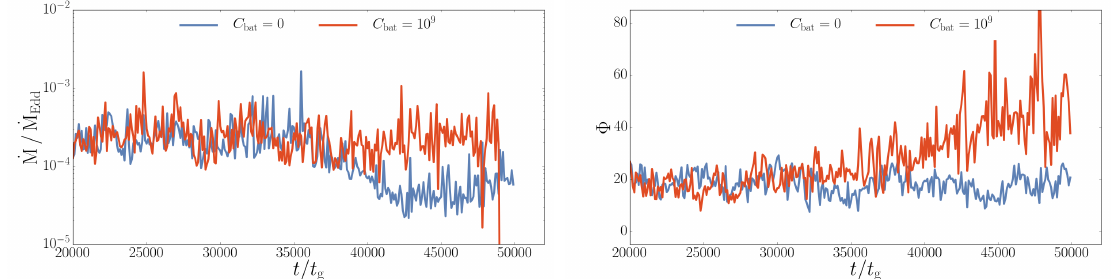
Figure 1. ( Left ) evolution of the mass accretion rate (in units of its Eddington value) in two 2D GR radiation MHD simulations, one with a random initial magnetic field (blue line), and one where the Cosmic Battery amplified by a factor of 10 9 is introduced after 20,000 gravitation time scales t g ≡ GM / c 3 (red line). After about 50,000 t g accretion stops (the black hole accretion rate ˙ M drops to zero) and a MAD state is reached. ( Right ) similarly for the magnetic flux Φ (in geometric units) threading the black hole horizon (from